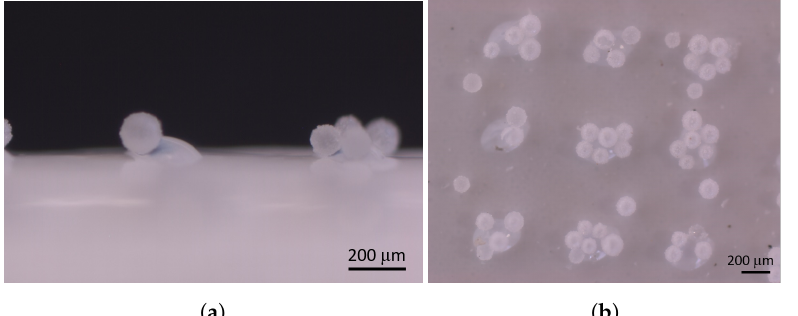
Figure 4. Optical microscopy images of the combined microcapsule membrane structure manufac- tured by the microdispensing approach (adhesive bonding). ( a ) Side view of microcapsules fixed on dispensed glue dots. ( b ) Top view on the membrane surface with the regular glue dot pattern and assemblies of